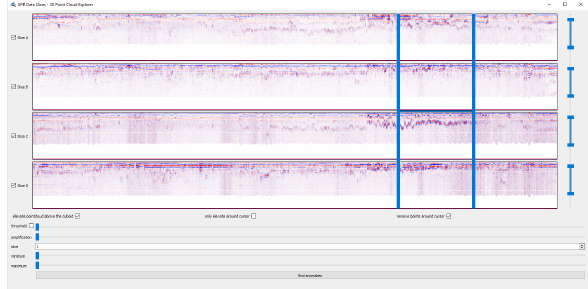
Figure 6. 2D User Interface for GPR data with cropping and thresholding